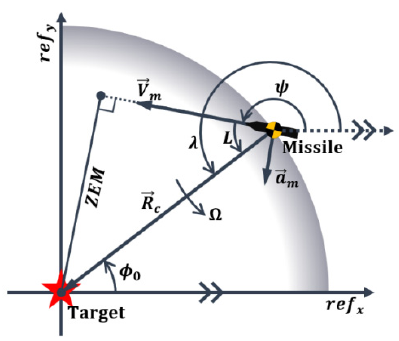
Figure 1. Geometry of a planar engagement scenario.